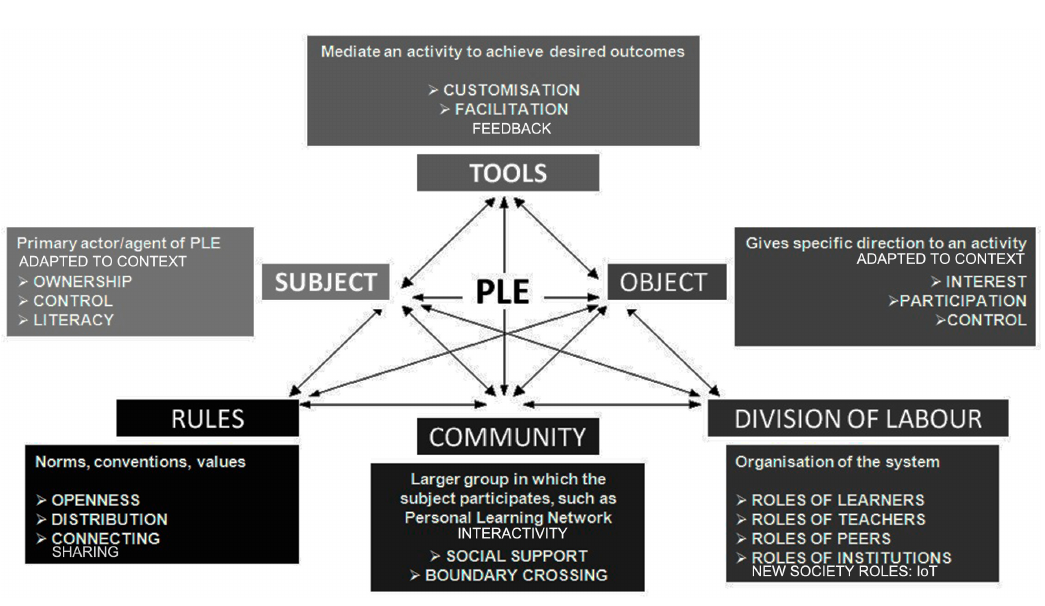
Figure 1. Elements of a personalized learning system (PLE), adapted from [33] (p. 30).